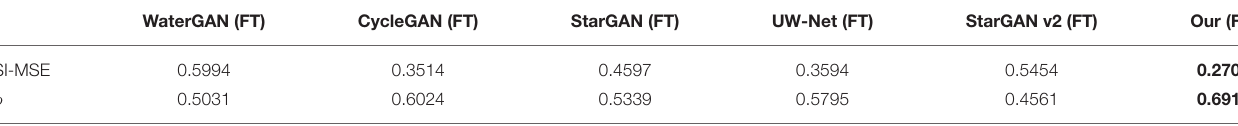
TABLE 1 | Quantitative comparison of our method and other methods for underwater image synthesis.